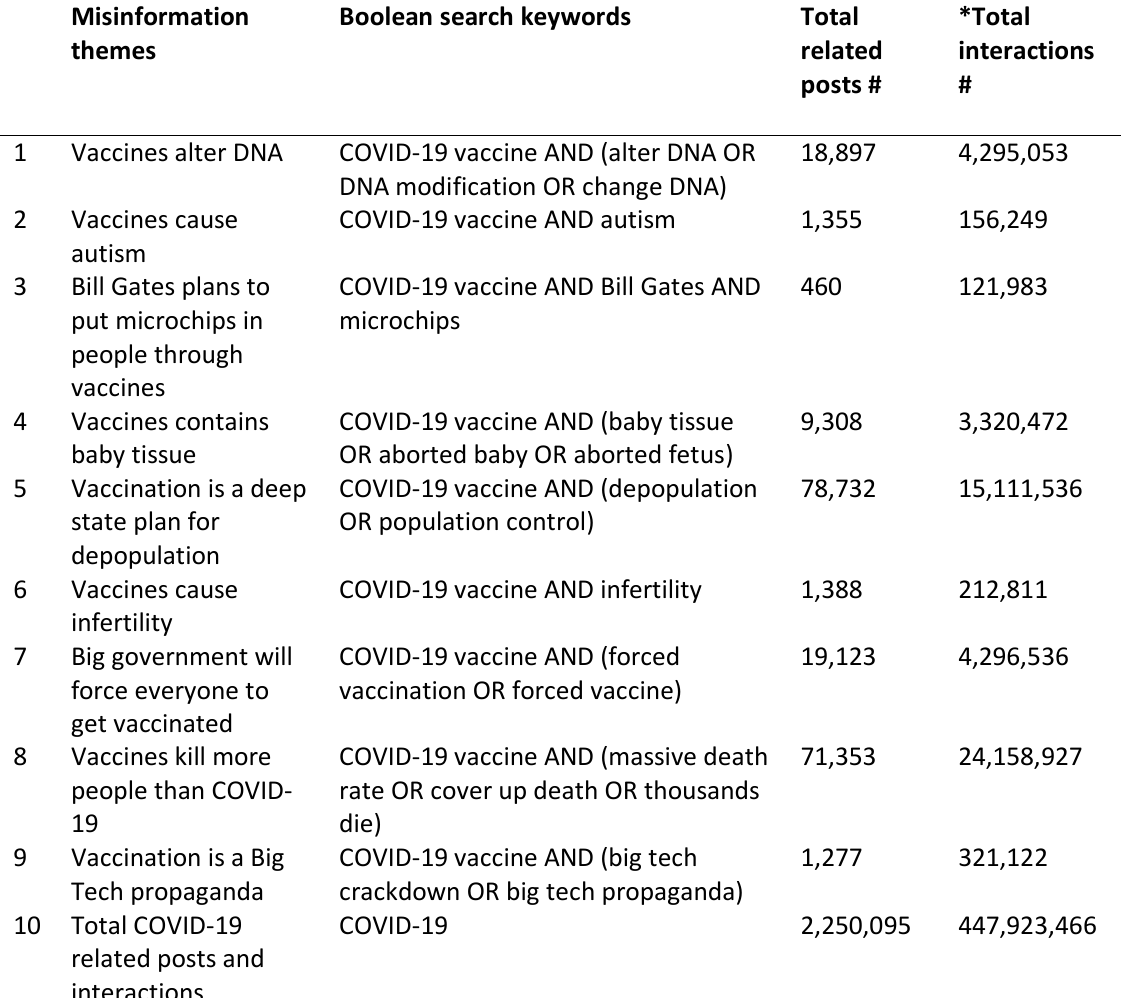
Table 1. COVID-19 vaccine misinformation vaccine themes between March 1 st , 2020 and March 1 st ,